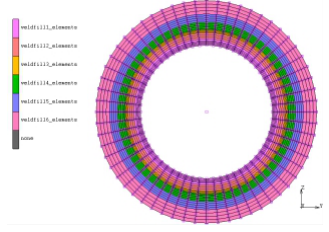
Figure 5. Setting pattern of the welding path